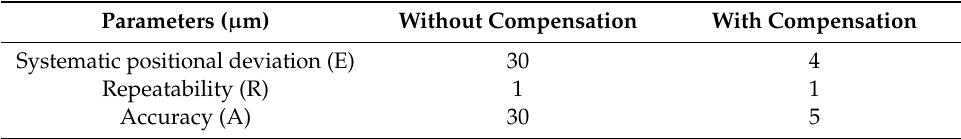
Table 4. Calibration results of the linear